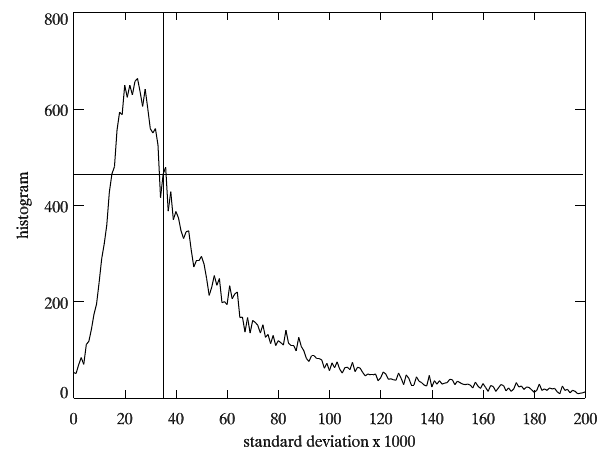
Fig. 3. Histogram of standard deviation σ τ points, the cross point of black vertical and horizontal lines rep- resents the chosen threshold